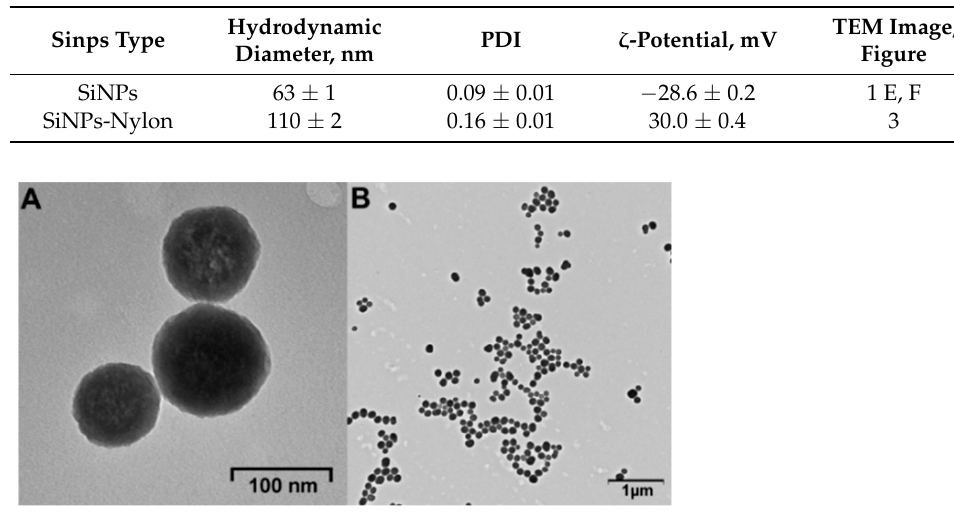
Figure 3. TEM image of SiNPs-Nylon. High magnification ( A ) and low magnification images ( B ).